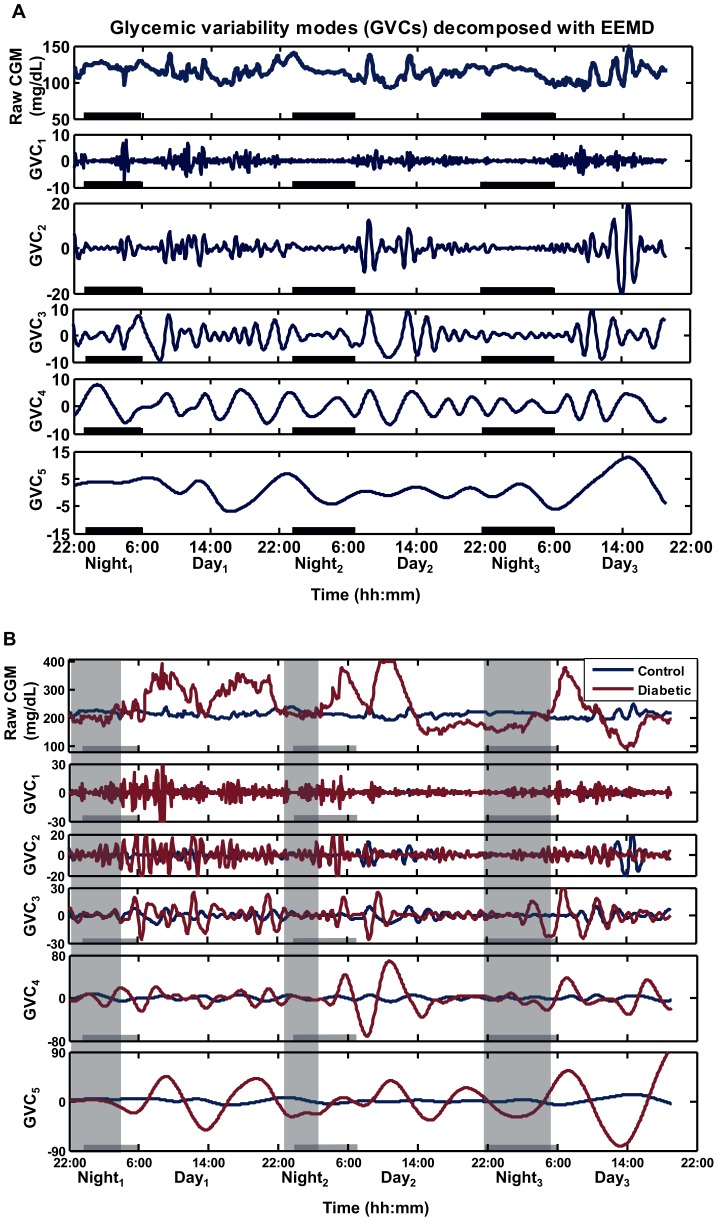
The Multi-Scale Glycemic Variability method applied to 3-day continuous glucose monitoring (CGM).The decomposition is based on the EEMD (Ensemble Empirical Mode Decomposition) technique. (A) The original CGM time-series from a representative control subject (male, 72 years old, HbA1c = 5.2%, SD (standard deviation) = 10.44, MAGE (mean average glycemic excursions) = 31.61) is decomposed into five glycemic variability cycles (GVCs) that are each characterized by fluctuations within a specific frequency band. The bold black lines along the X-axis denote sleep periods defined by actigraphy and patient records. (B) Comparison of raw CGM signals and selected GVCs between the control subject in (A) and a representative patient with type2 DM (male, 62 years old, HbA1c = 9.4%, SD = 71.36, MAGE = 161.85). The shading areas denote sleep for the type 2 DM patient, while the bold black lines along the X-axis denote sleep for the control subject.